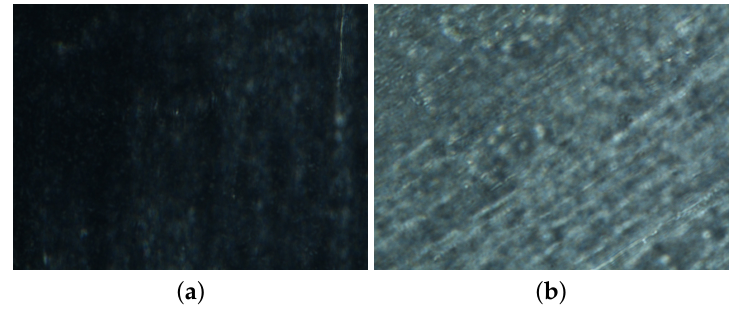
Figure 6. Preoriented liquid crystal cell with double deposition of PI+PC observed between crossed polarizers. ( a ) Orientation parallel to one of the polarizers. ( b ) Orientation 45 ◦ to the polarizers.